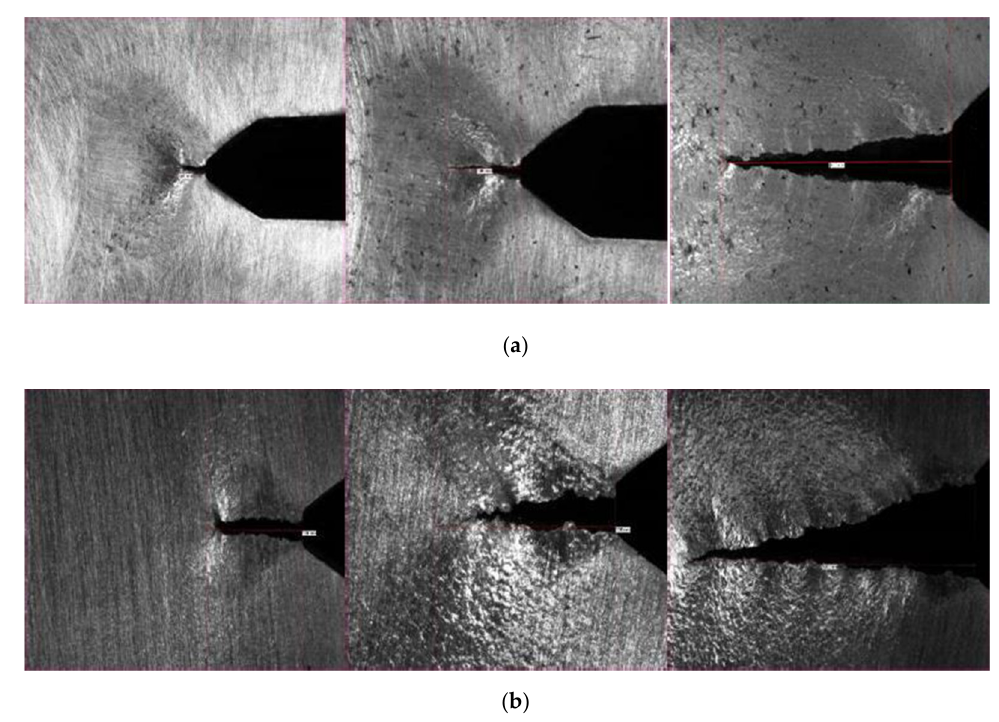
Figure 13. Crack growth sequence example ( a ) Bembézar Stringers; ( b ) Bembézar Main Chords. The width of each image corresponds to 5 mm.